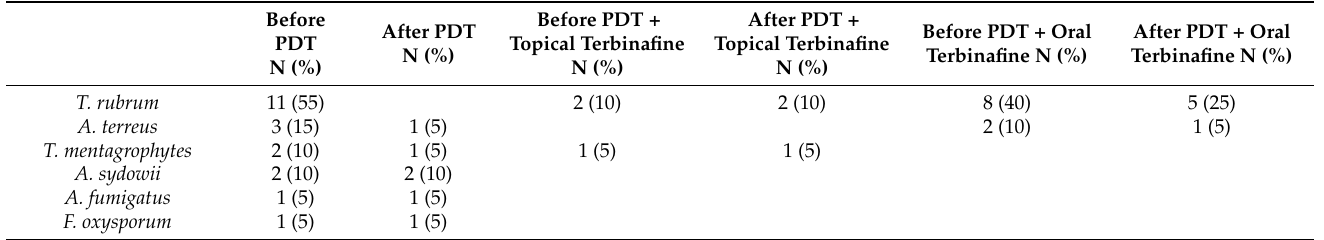
Table 3. Microbiological cure after PDT alone or combined with terbinafine, according to causative